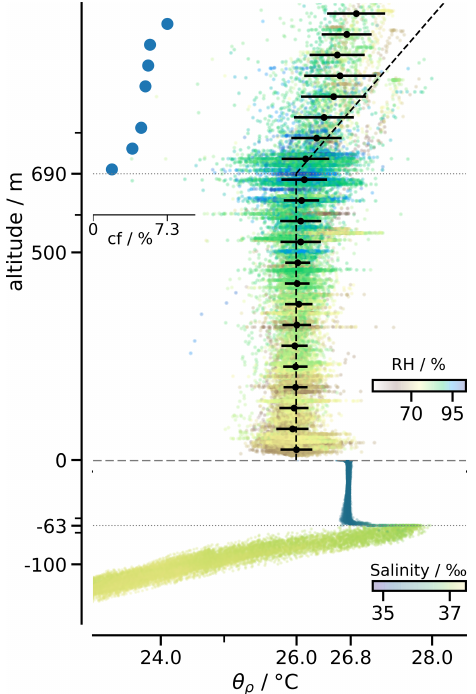
Figure 8. Ocean and atmospheric boundary layer upwind of the BCO. Dots show CU-RAAVEN measurements of the density po- tential temperature vs. altitude, as well as underwater glider mea- surements of the temperature below the surface. Values are normal- ized to compensate for differences associated with either synoptic variations or from variations in the depth of the sampled planetary boundary layers. Blue dots show profile of cloud fraction from all MPCK profiles. The dashed (black) line marks the potential temper- ature of near-surface air isentropically lifted from the surface; the slope discontinuity at the lifting condensation level (690m) marks the shift from an unsaturated to a saturated isentrope. The tempera- ture difference between the sea surface and the lower atmosphere is taken from Saildrone